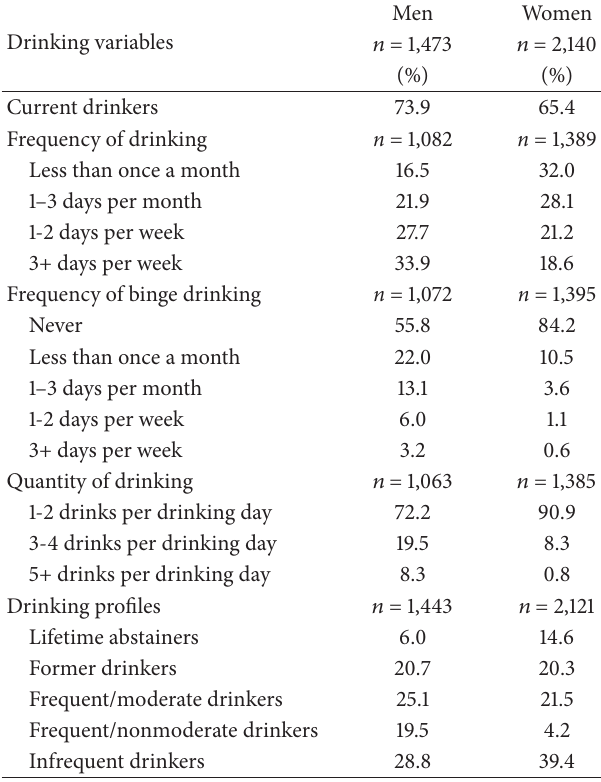
Table 1: Drinking characteristics of men and women, 55–74 years of age ( 𝑛 =